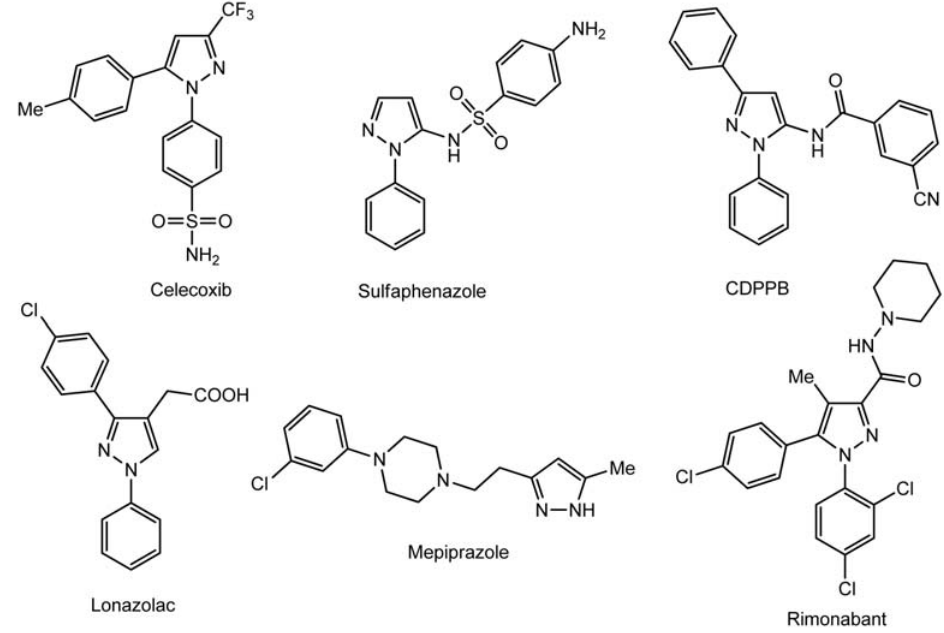
Figure 1. Biologically active pyrazole